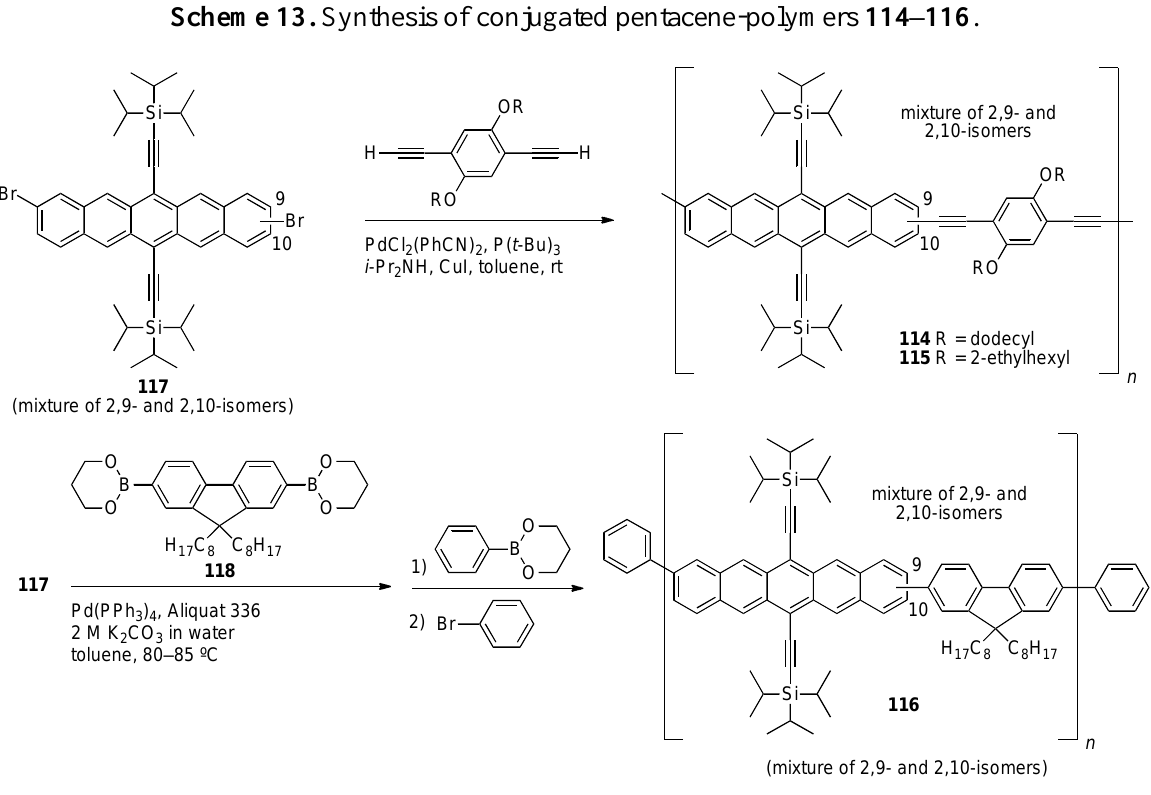
Table 3. Optical and electrochemical properties of polymer 114–116 and compared to monomer 1 .